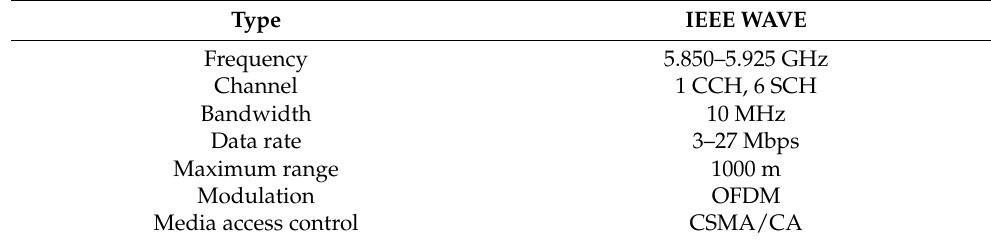
Table 3. Dedicated short-range communications (DSRC)-based vehicle-to-everything (V2X) commu- nications